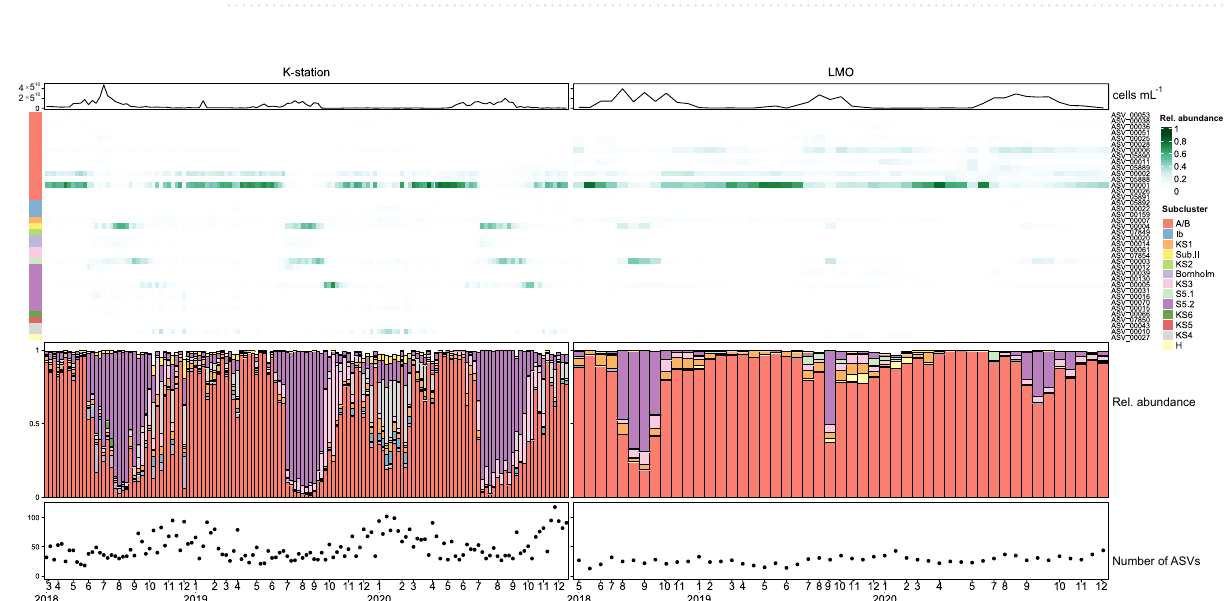
Figure 3. Relative abundance of ASVs with contribution > 1% to the total Synechococcus community in the K-station and LMO. The line plot on top represents total picocyanobacterial abundance for each sampling point. The heatmap represents the relative abundance of each ASV for each sampling point. The color code on the left indicates the clade of each ASV represented on the heatmap. The bottom barplot indicates the relative abundance of each subgroup/clade to the total Synechococcus community. The bottom dot plot indicates the number of ASVs for each sampling